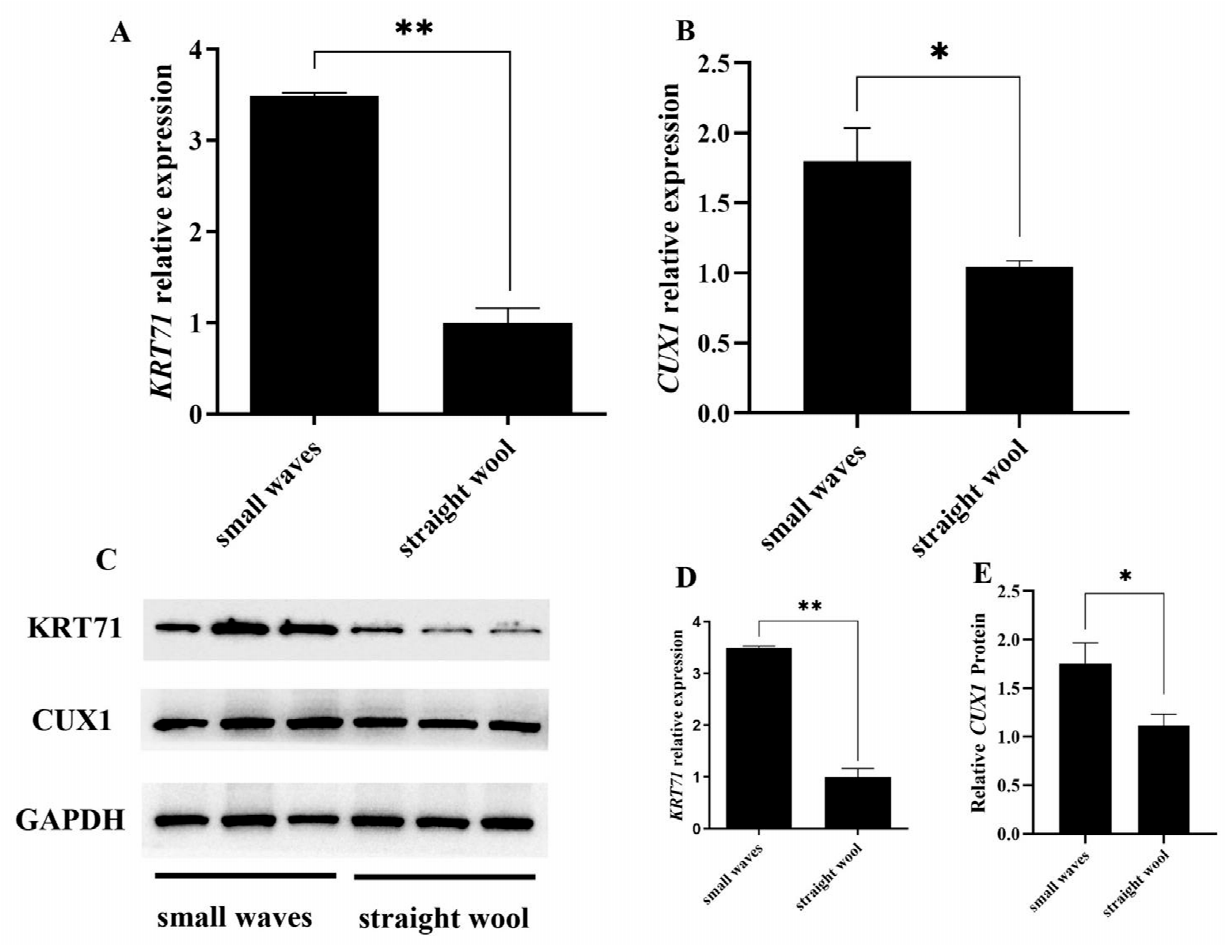
Figure 4. The expression levels of CUX1 and KRT71 in small waves and straight wool group. ( A ) The relative mRNA expression levels of CUX1 were significantly higher in small waves group, as indicated by qRT-PCR. ( B ) The relative mRNA expression levels of KRT71 were significantly higher in small waves group, as indicated by qRT-PCR. ( C – E ) The protein expression levels of CUX1 and KRT71 in small waves group were higher than those in straight wool, as indicated byWestern blot. * p < 0.05, ** p < 0.01.